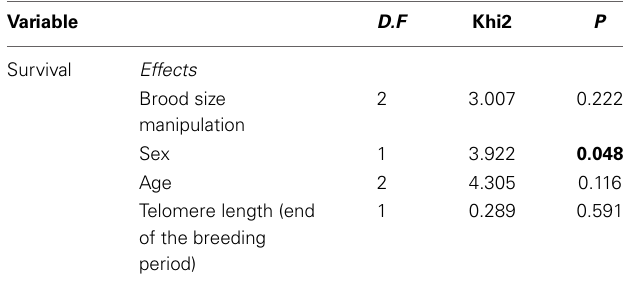
Table 2 | Results of the binomial GLMM on survival a year after the breeding event with the experimental group, sex, age, and telomere length at the end of the breeding period were entered as explanatory